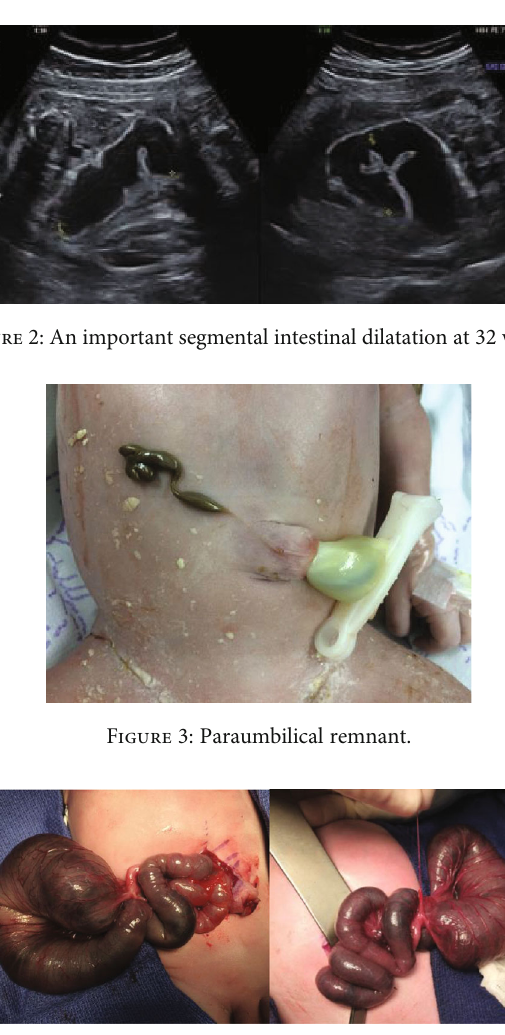
Figures 4: Explorative laparotomy, fi brous cord connected to paraumbilical